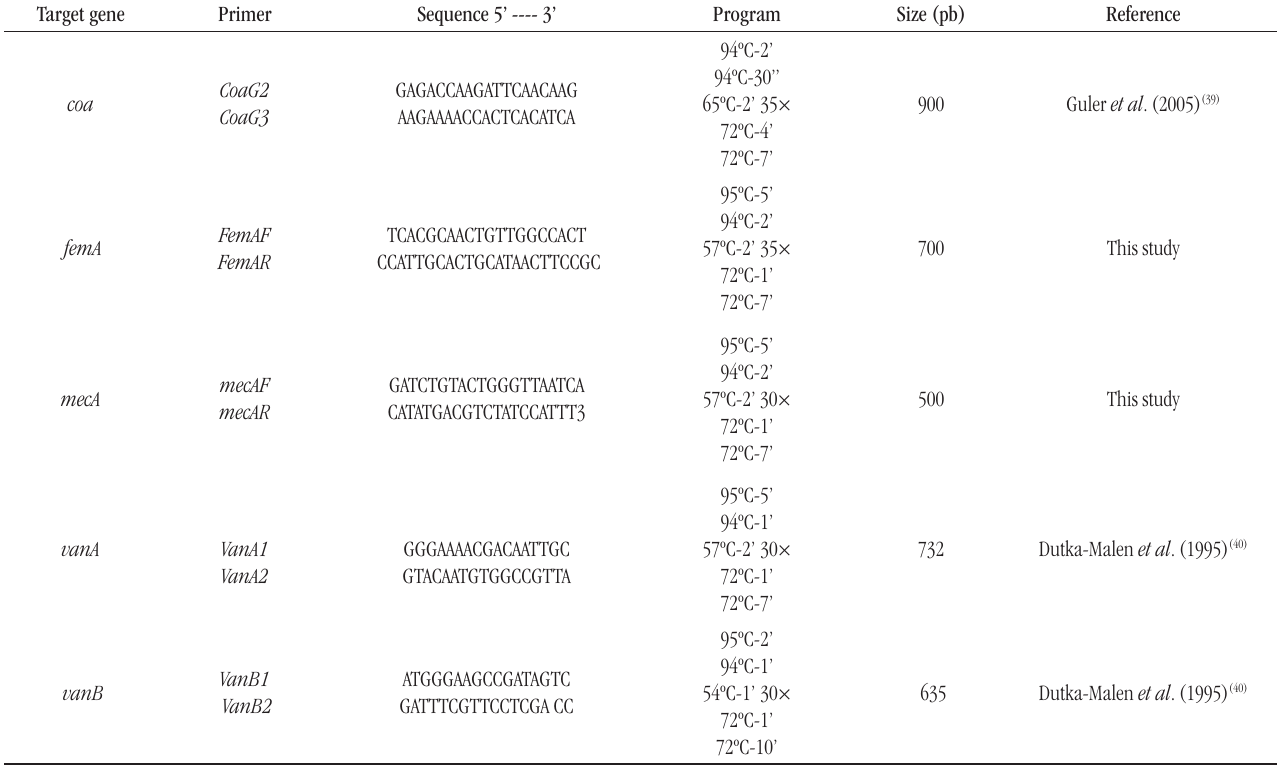
taBLE 1 – Genes, primers, and PCR